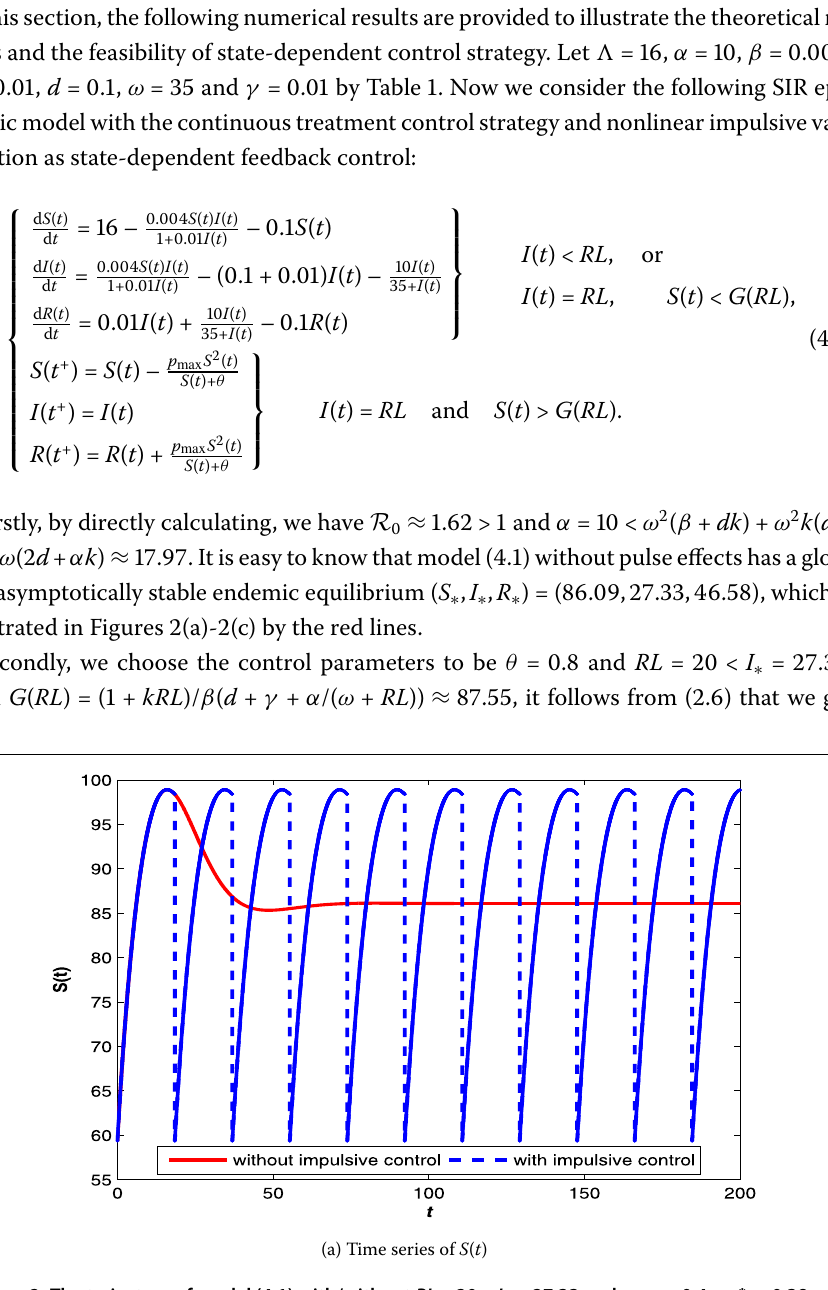
Figure 2 The trajectory of model (4.1) with/without RL = 20 < I ∗ = 27.33 and p max = 0.4 > p ∗ ≈ 0.38. The initial value is ( S 0 , I 0 , R 0 ) =